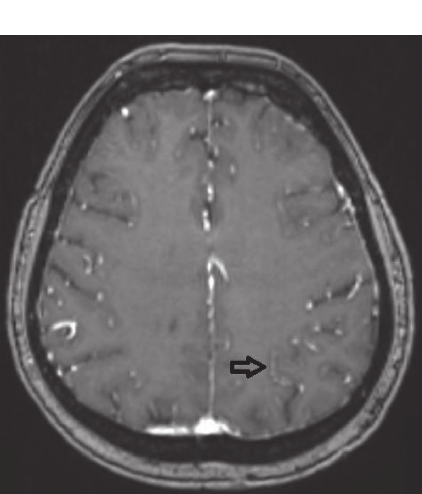
Figure 2: MRI from June 2012 showing hyperperfusion of the leptomeningeal arteries (black